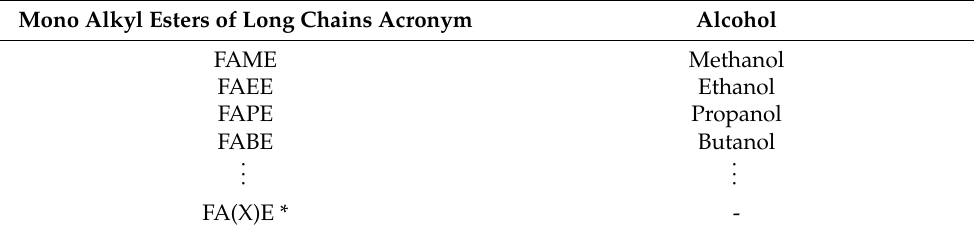
Table 1. Acronyms of mono alkyl esters in function of the alcohol.